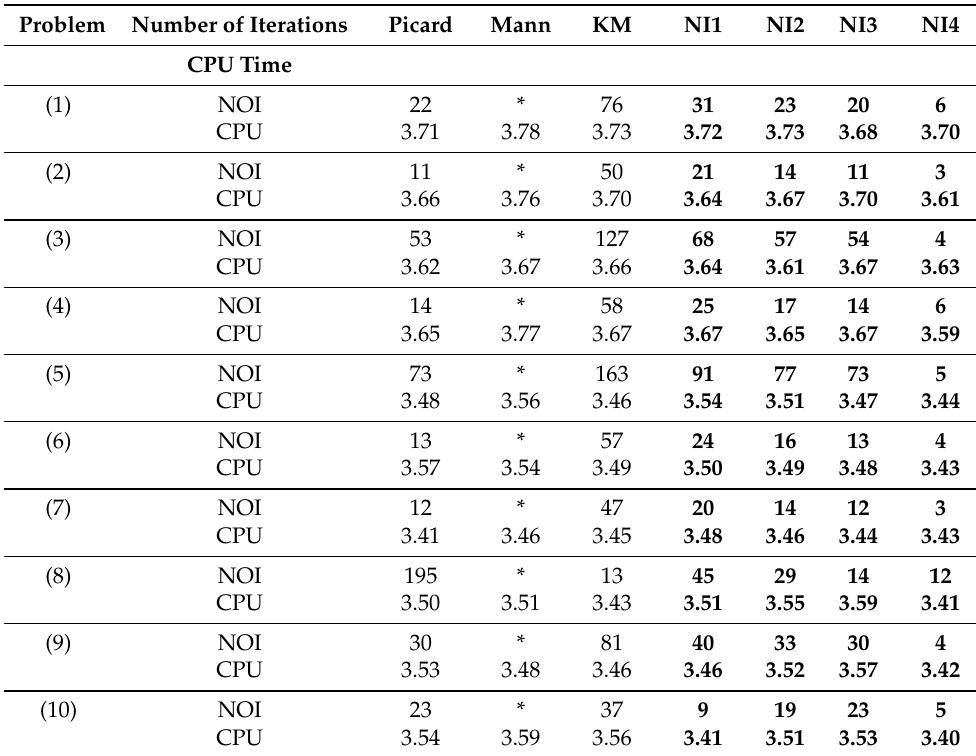
Table 2. Comparison of different fixed point methods on problems in Table 1.